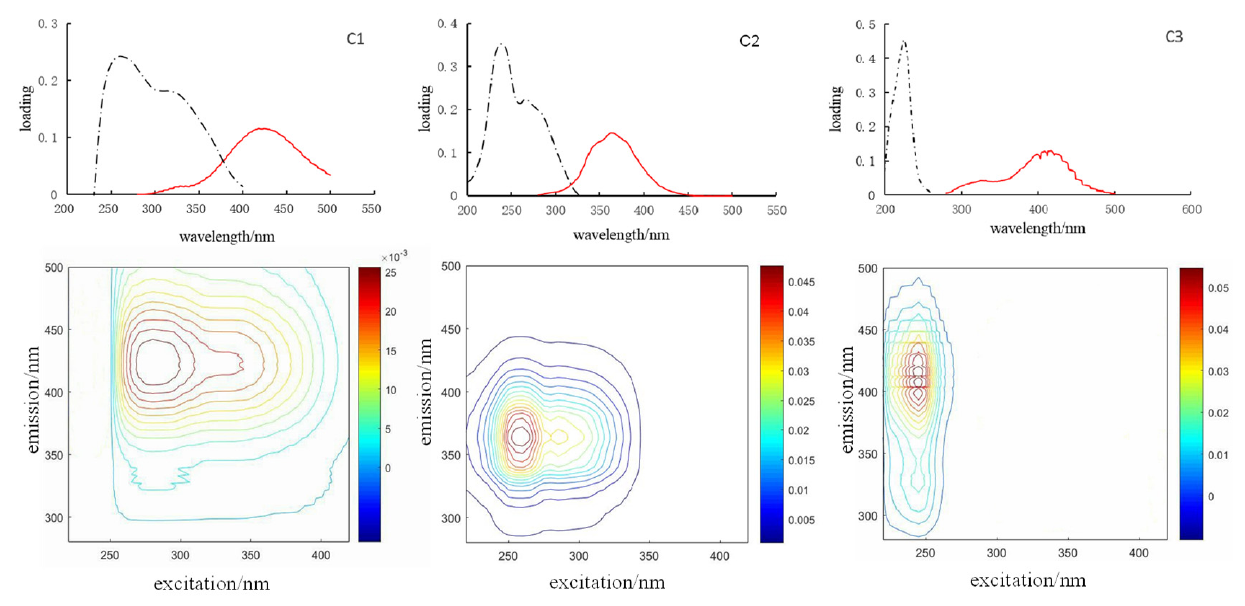
Figure 4. Excitation (black dotted lines), emission loadings (red solid lines) and contour plots of component 1, component 2 and component 3 for the whole dataset. Table 2. Characteristics of the three fluorescence components from the water regimes of the Qilianshan re- gion.